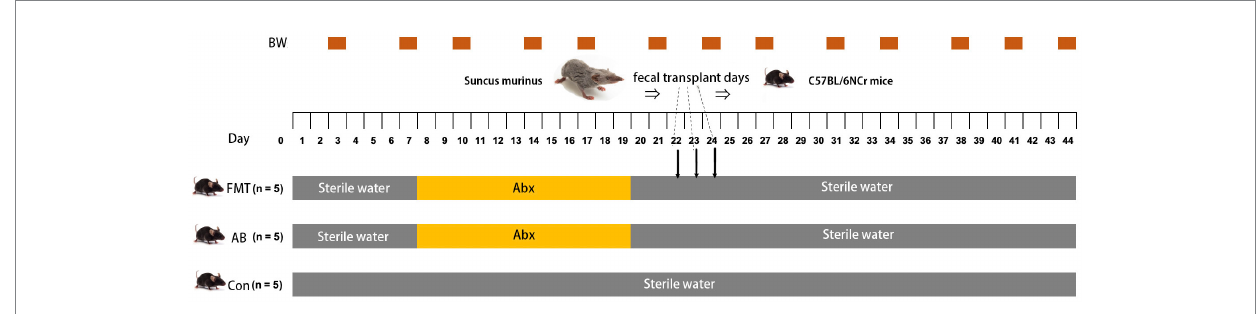
FIGURE 1 Schedule of antibiotic treatment period (Abx), fecal microbiota transplantation (FMT) and body weight measurements (BW). FMT, FMT group; AB, antibiotic group; Con, Control